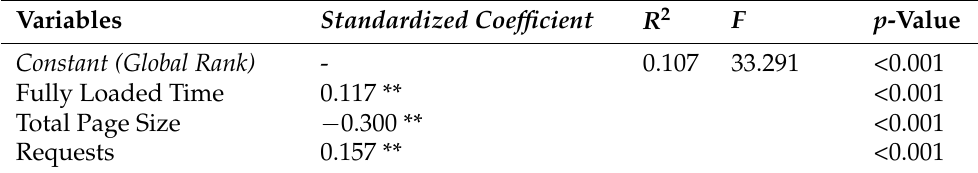
Table 12. Fifth hypothesis’